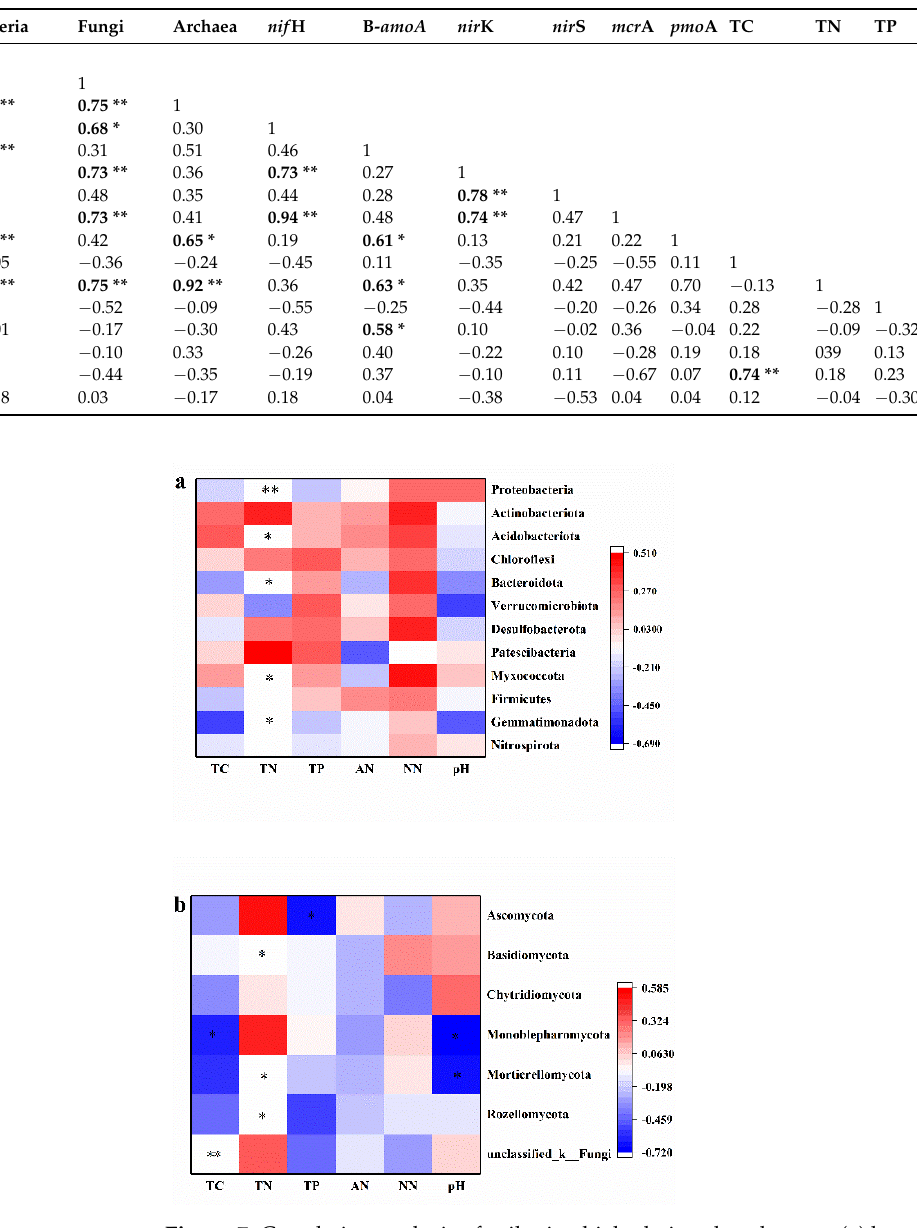
Table 2. Pearson correlation analysis of soil microbial abundance and soil chemical properties. TC: total carbon; TN: total